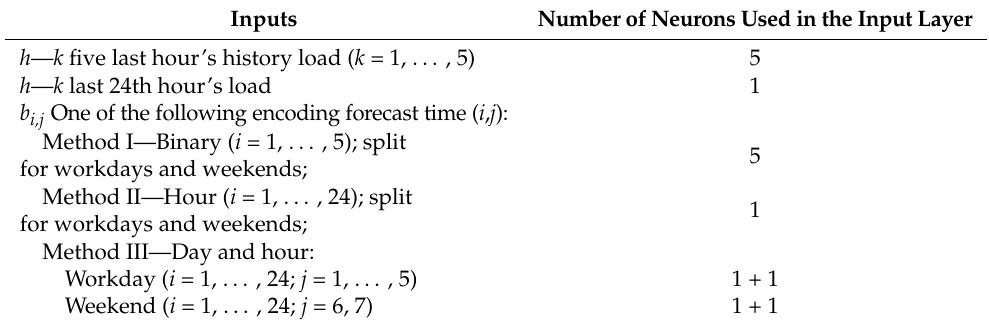
Table 1. ANN inputs and neurons used. Inputs Number of Neurons Used in the Input Layer